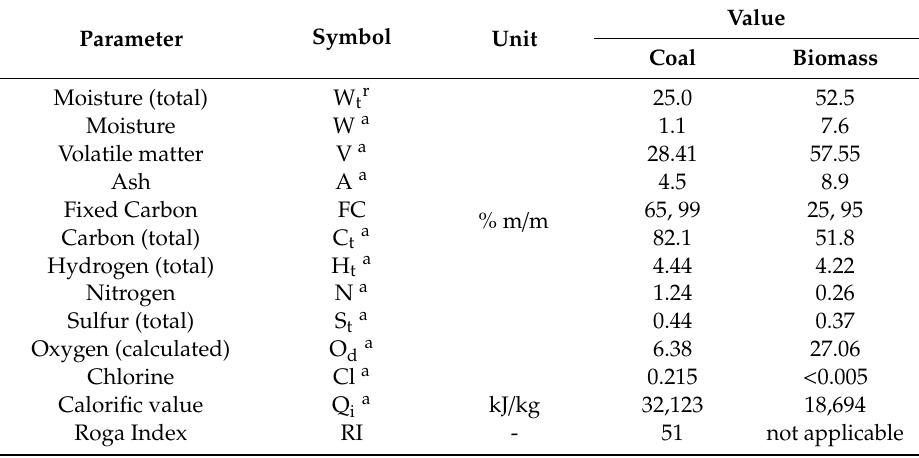
Table 1. Properties of raw materials used.